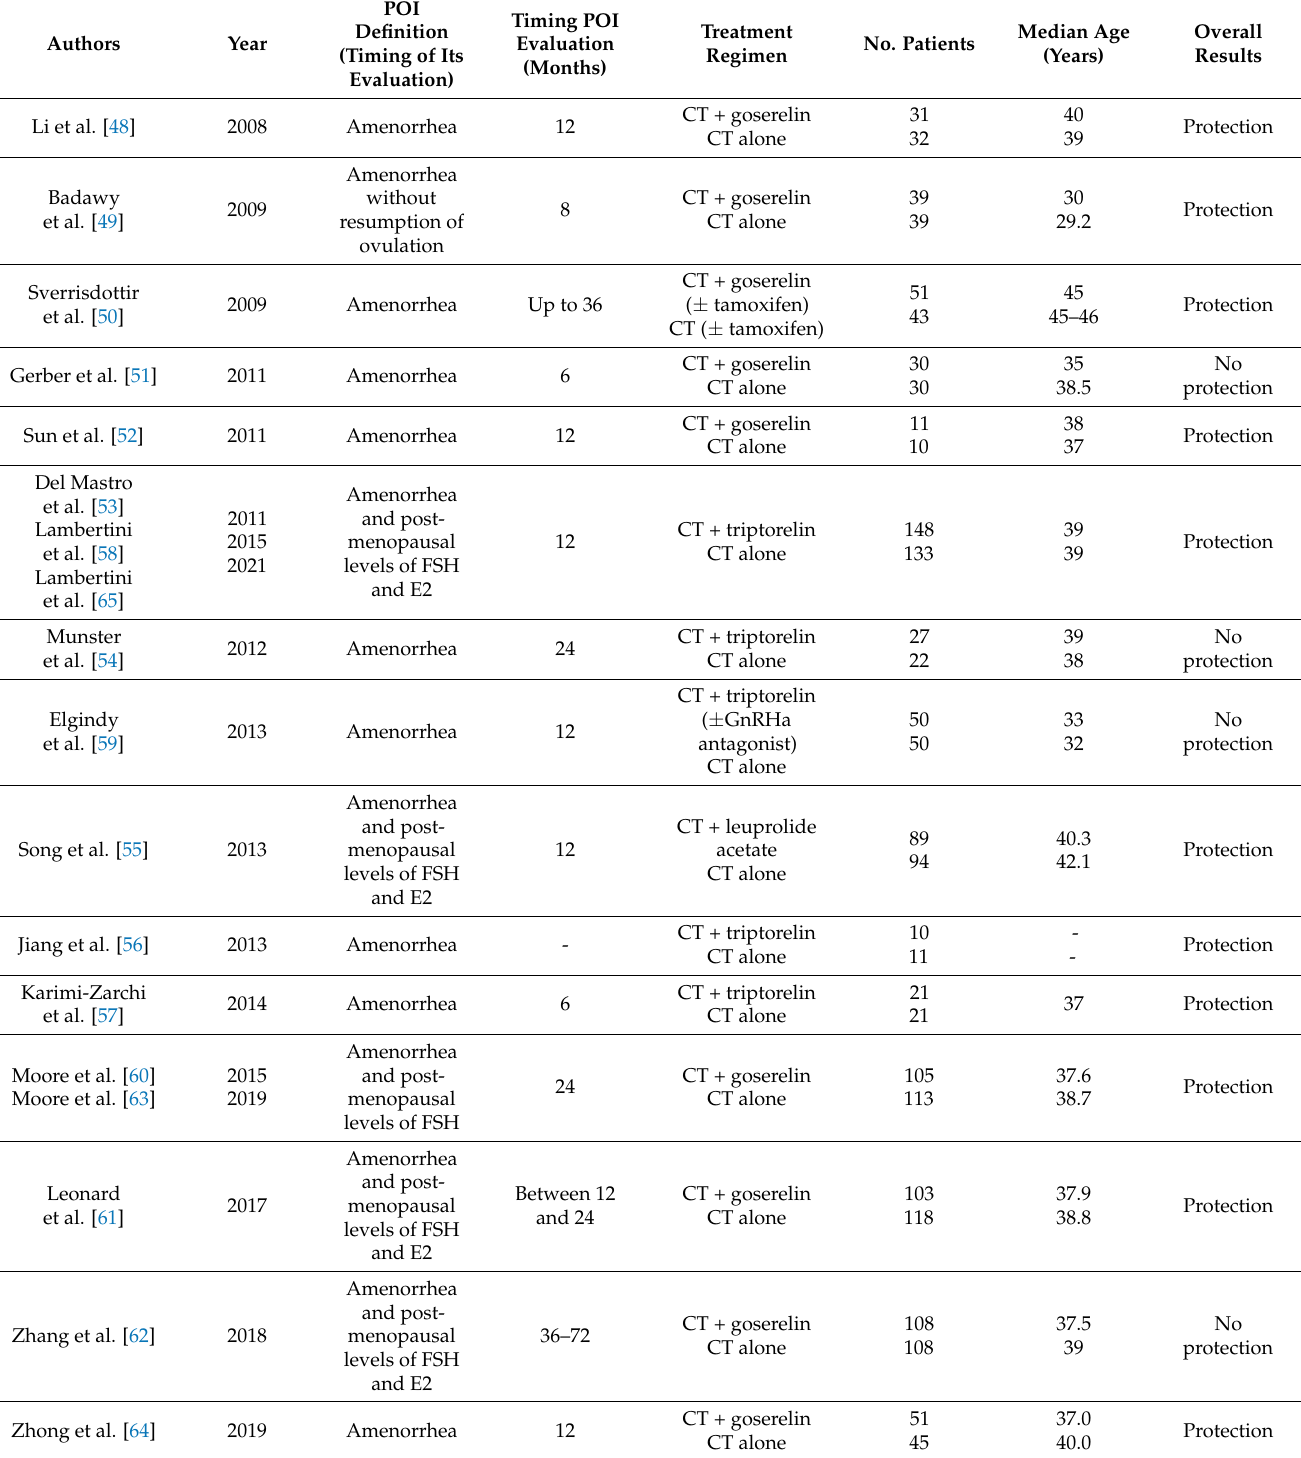
Table 1. Randomized trials evaluating temporary ovarian suppression with GnRHa during chemotherapy in breast cancer